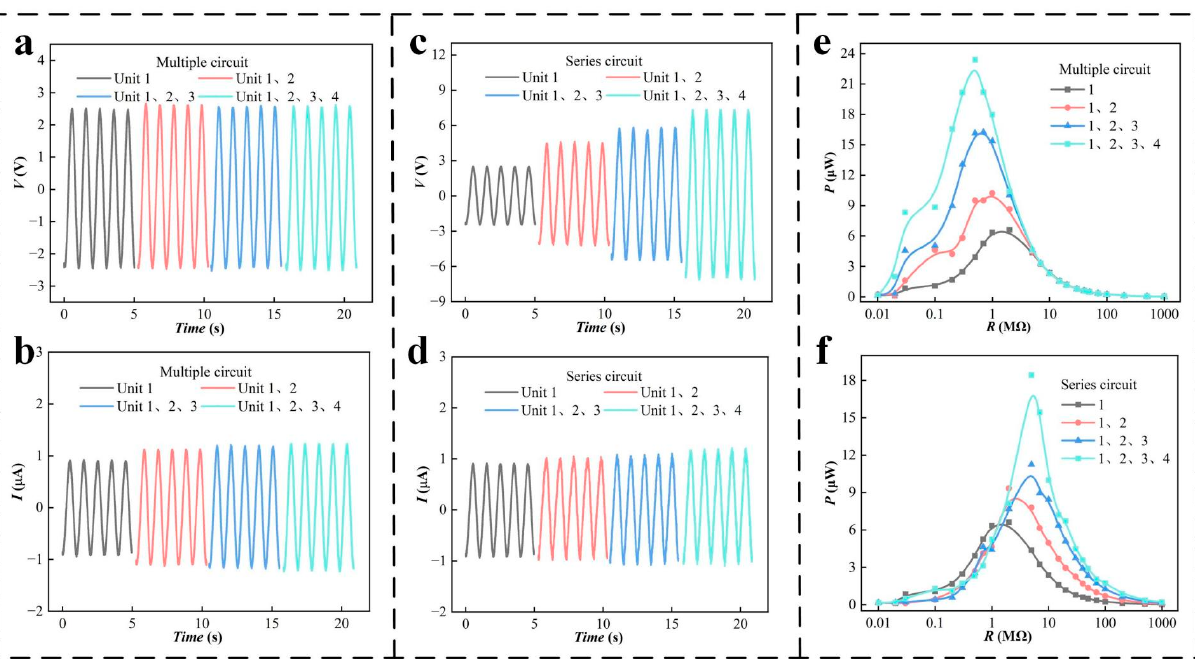
Figure 5. Output performances of parallel and series PZT units: ( a , b ) voltage, ( V ) and current, ( I ) output performances of the parallel circuit, ( c , d ) V and I output performances of the series circuit, ( e , f ) power output curves of the parallel and series circuits.